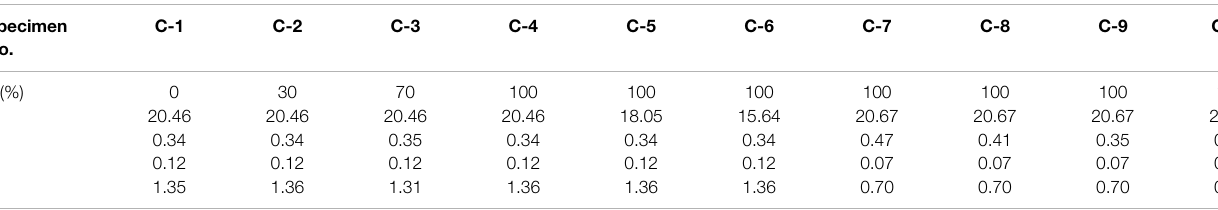
TABLE 1 | Design parameters of specimens.